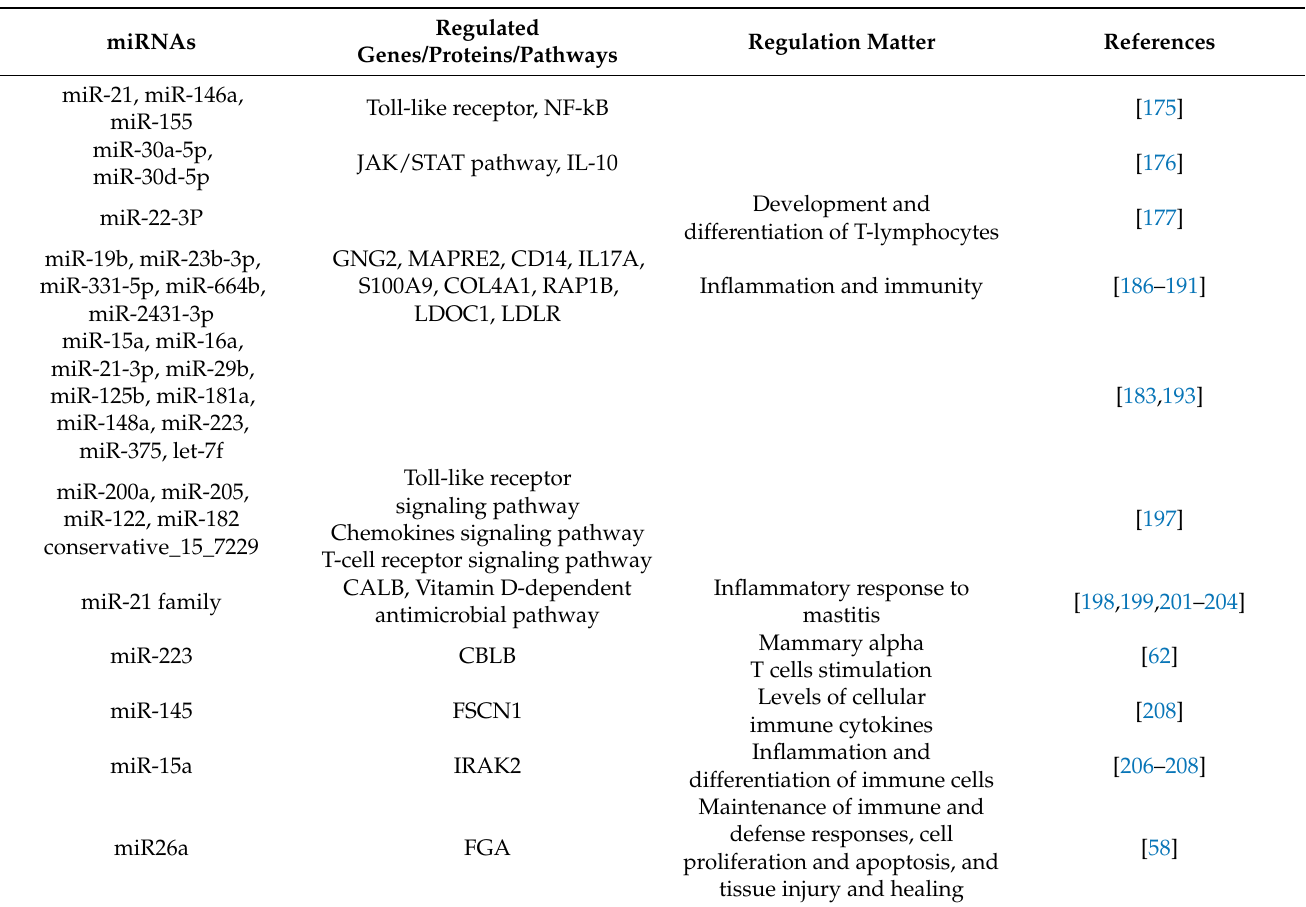
Table 8. A brief summary of some miRNAs roles in the control of the mammary immune system.